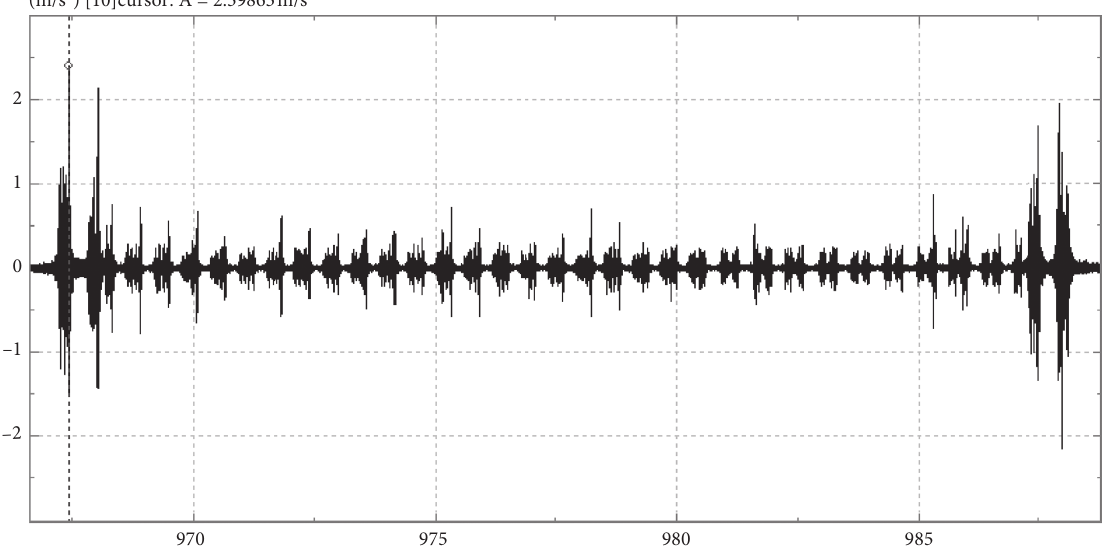
Figure 22: Time domain characteristic diagram of vibration acceleration along the line direction ( Y -axis) in the repair